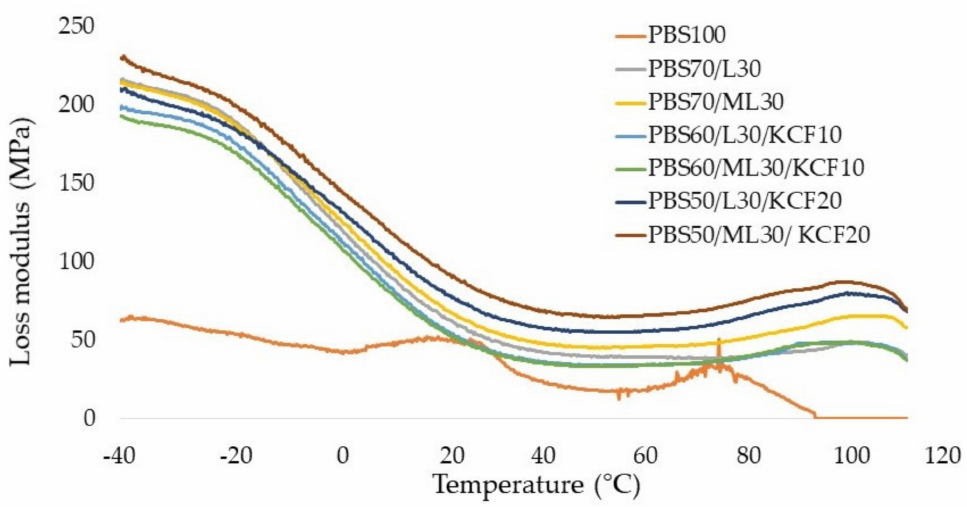
Figure 4. Loss modulus (E”) of the composites prepared from an unmodified and modified lignin blend with PBS and kenaf core fibers.